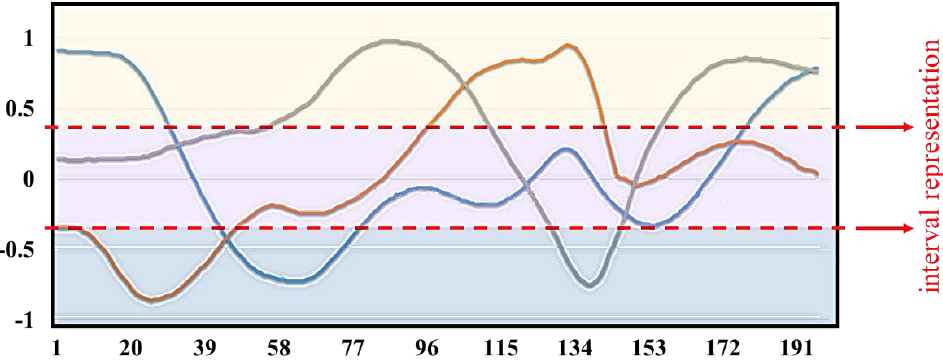
Figure 6. Acceleration signal after normalization procedure and its interval definition. The x-axis acceleration signal is represented by a blue line, the y-axis acceleration signal is represented by an orange line, and the z-axis acceleration signals is represented by a gray line.